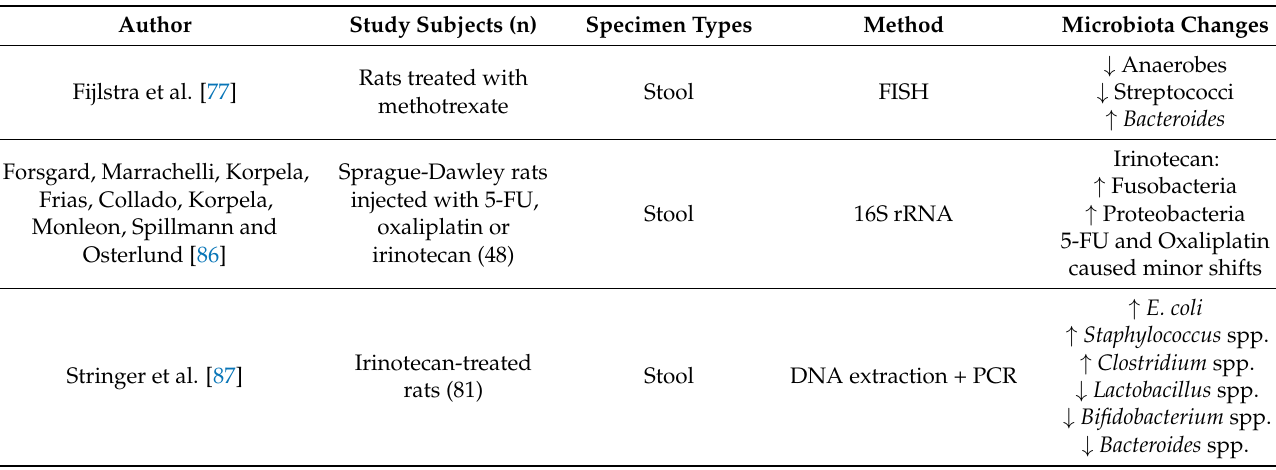
Table 2. Stool and Mucosal Dysbiosis following Chemotherapy in